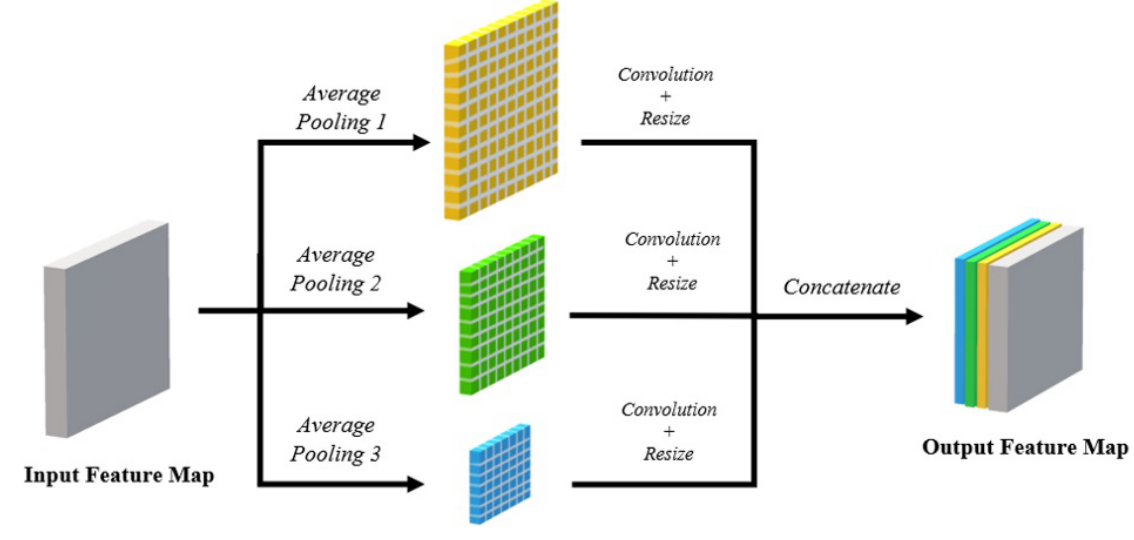
Figure 3. Network architecture of a spatial pyramid pooling mechanism.